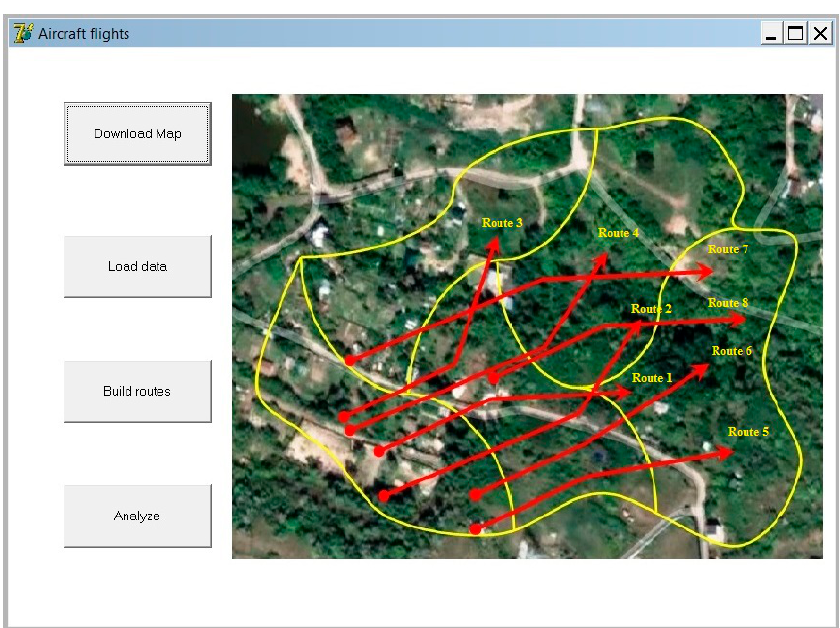
Figure 5. A fragment of the map of the flight area of unmanned aerial vehicles.